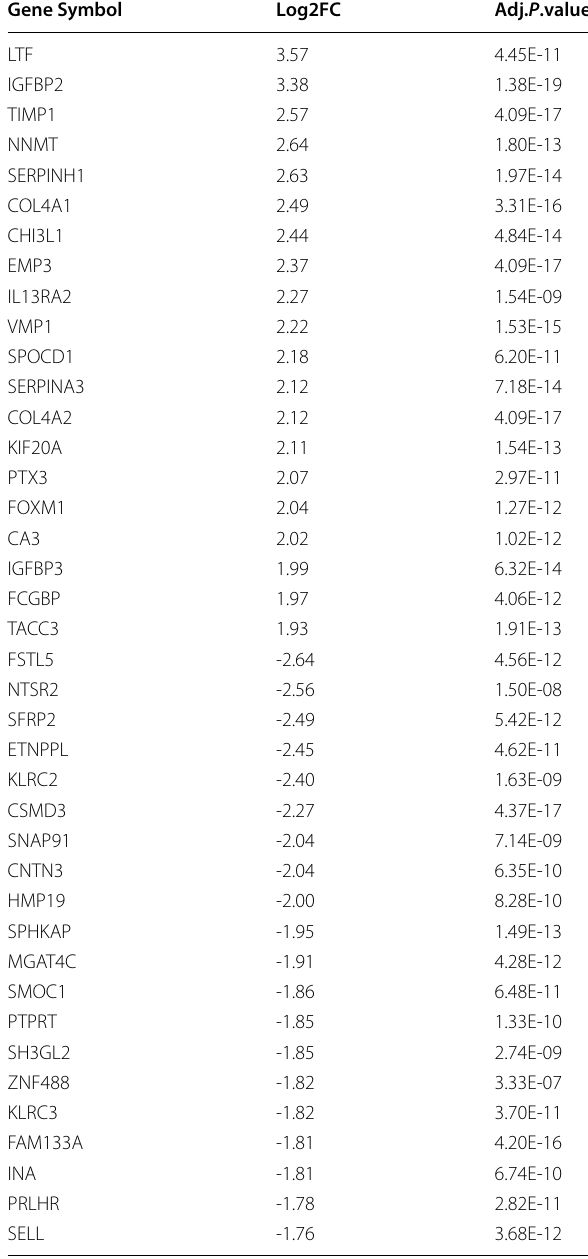
Table 1 Top 20 up‑regulated and down‑regulated differentially expressed genes between LGG and